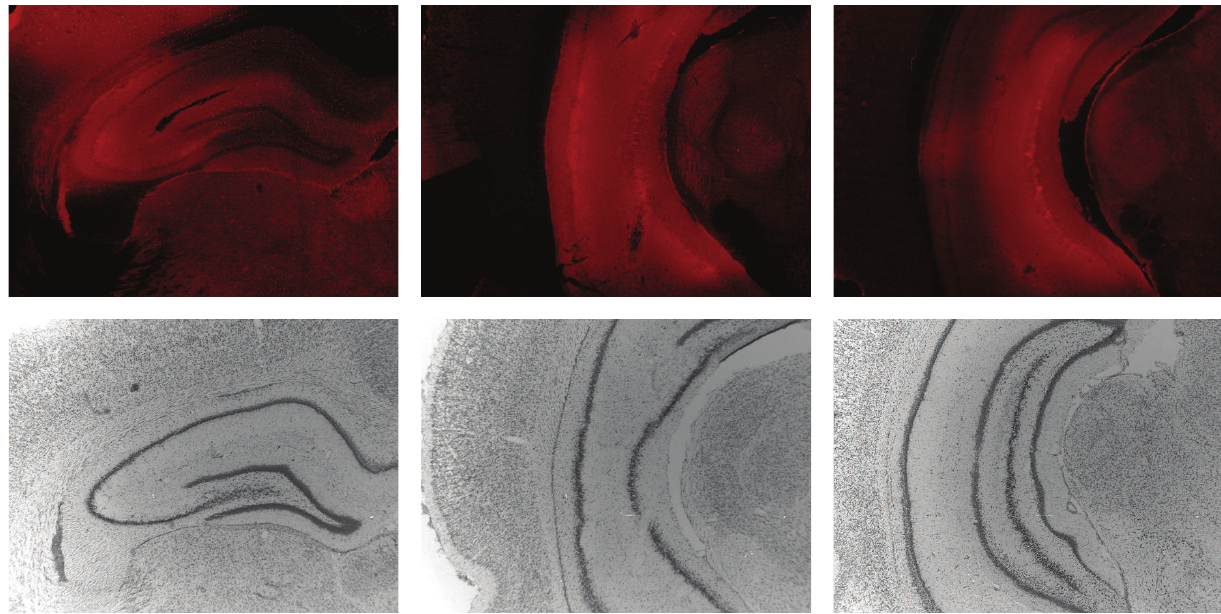
Figure 1: Photographs at three coronal levels for a rat with hippocampal infusion of ZIP (anterior to posterior from left to right; lateral to the left of each section and medial to the right). Top: fluorescence images depicting the extent of the ZIP infusion throughout all cell layers of dorsal, intermediate, and ventral hippocampus, while remaining confined to the hippocampus. Some sparing was noted in the most medial aspects of the dorsal hippocampus. The only biotin-labeled ZIP outside of the hippocampus was the result of diffusion along the needle track. Bottom: corresponding tissue stained with thionin to visualize the hippocampal cell